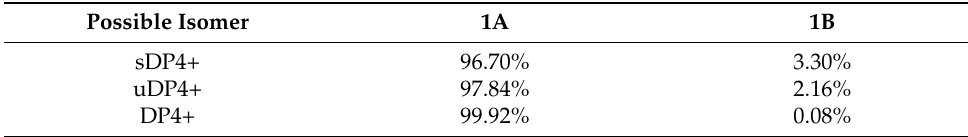
Figure 4. Relative errors and standard deviation between calculated and experimental 13 C chemical shifts of two potential isomers. Table 2. DP4+ probability of 13 C NMR of 1 .